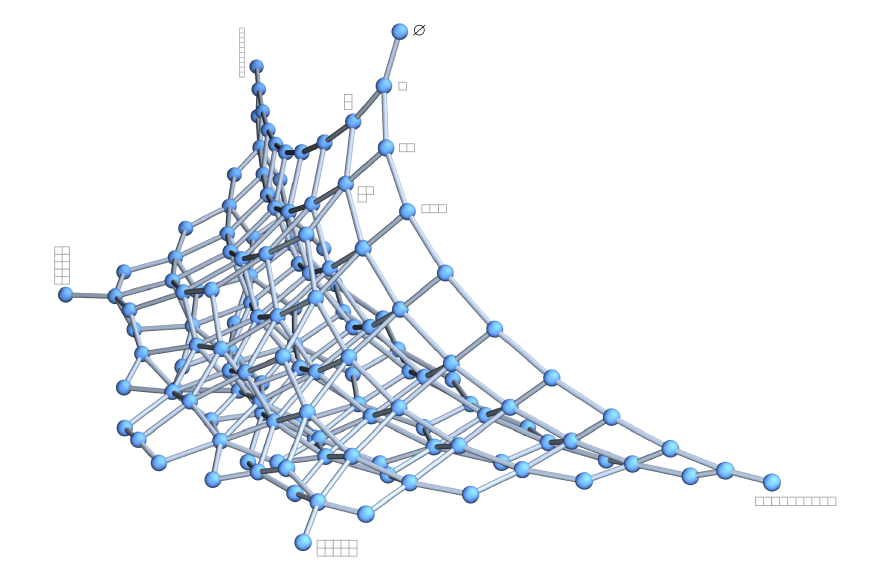
Figure 3 . A 3d view of the Young’s lattice till level 10. Some of the vertices have been marked by the Young diagrams. (This can be generated in Mathematica using the function GraphPlot3D with the adjacency matrix of the Young’s lattice as the